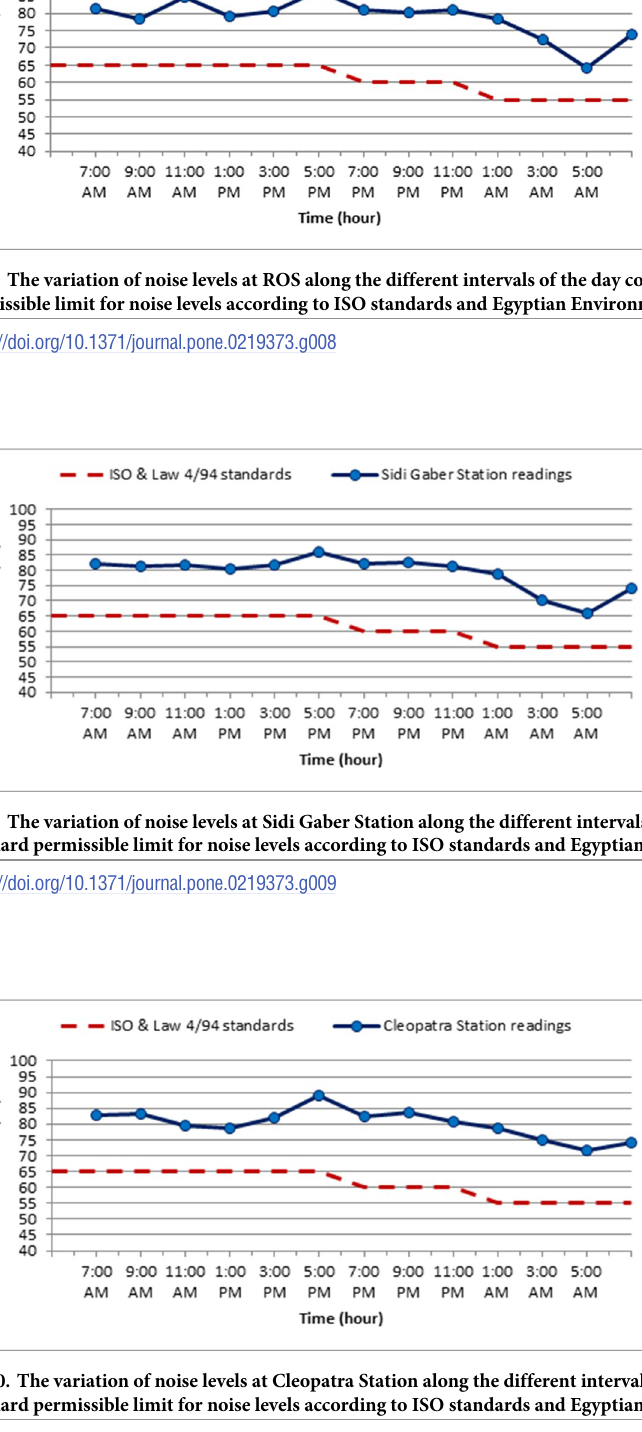
PLOS ONE | https://doi.org/10.1371/journal.pone.0219373 July 11,